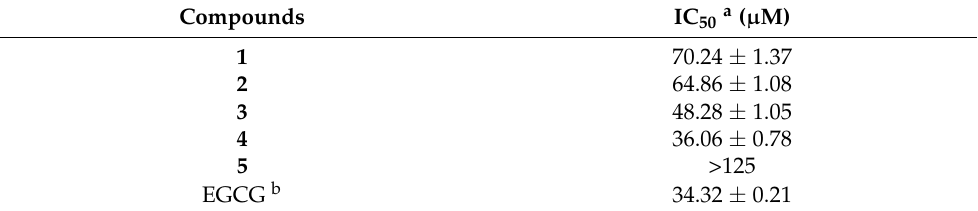
Table 2. Anti-collagenase activity of compounds 1 – 5 and their respective IC 50